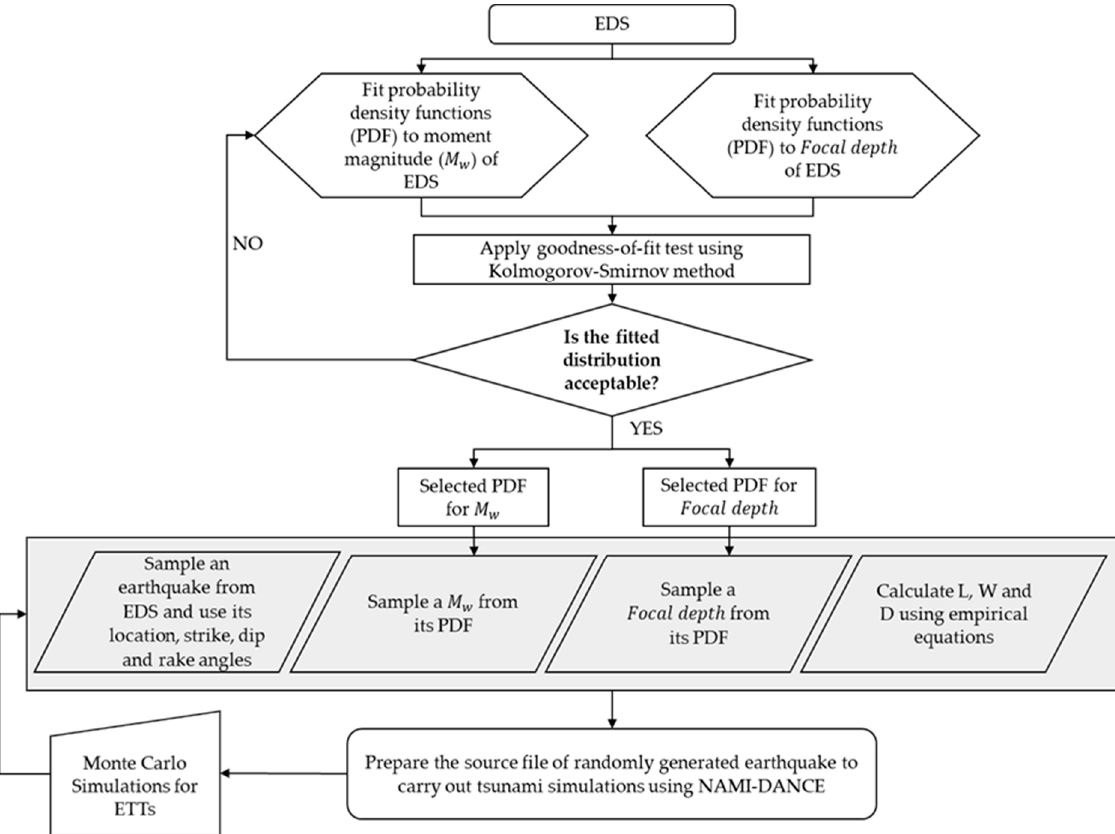
Figure 4. Flowchart for the application procedure of MC simulations [24].